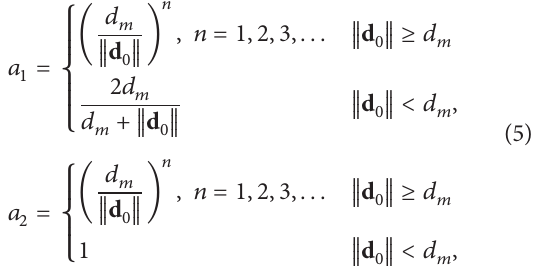
Figure 4: The condition of obstacles appears in the desired trajec-